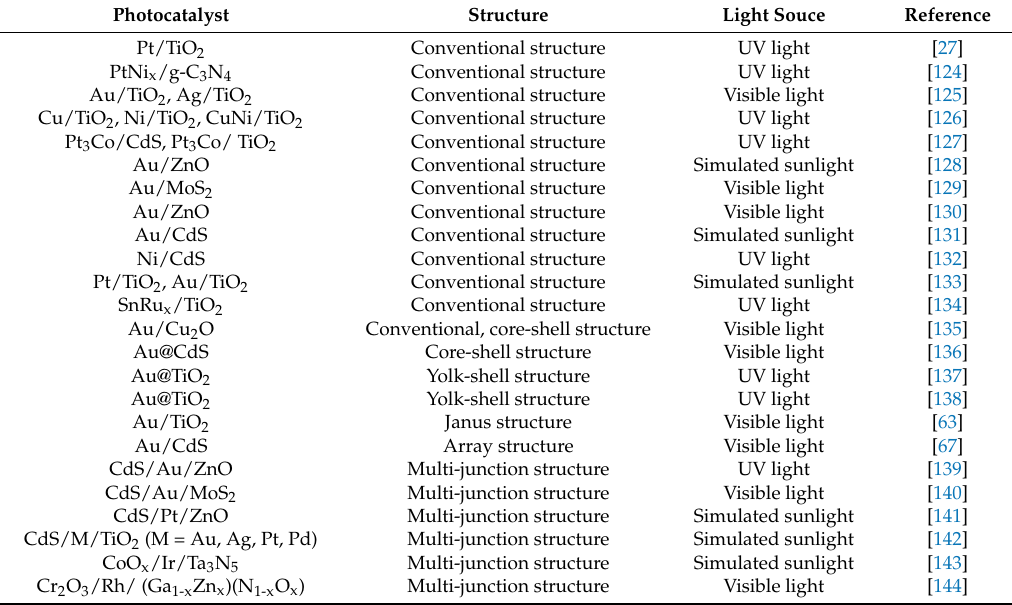
Table 3. M/S nanocomposite photocatalysts for hydrogen